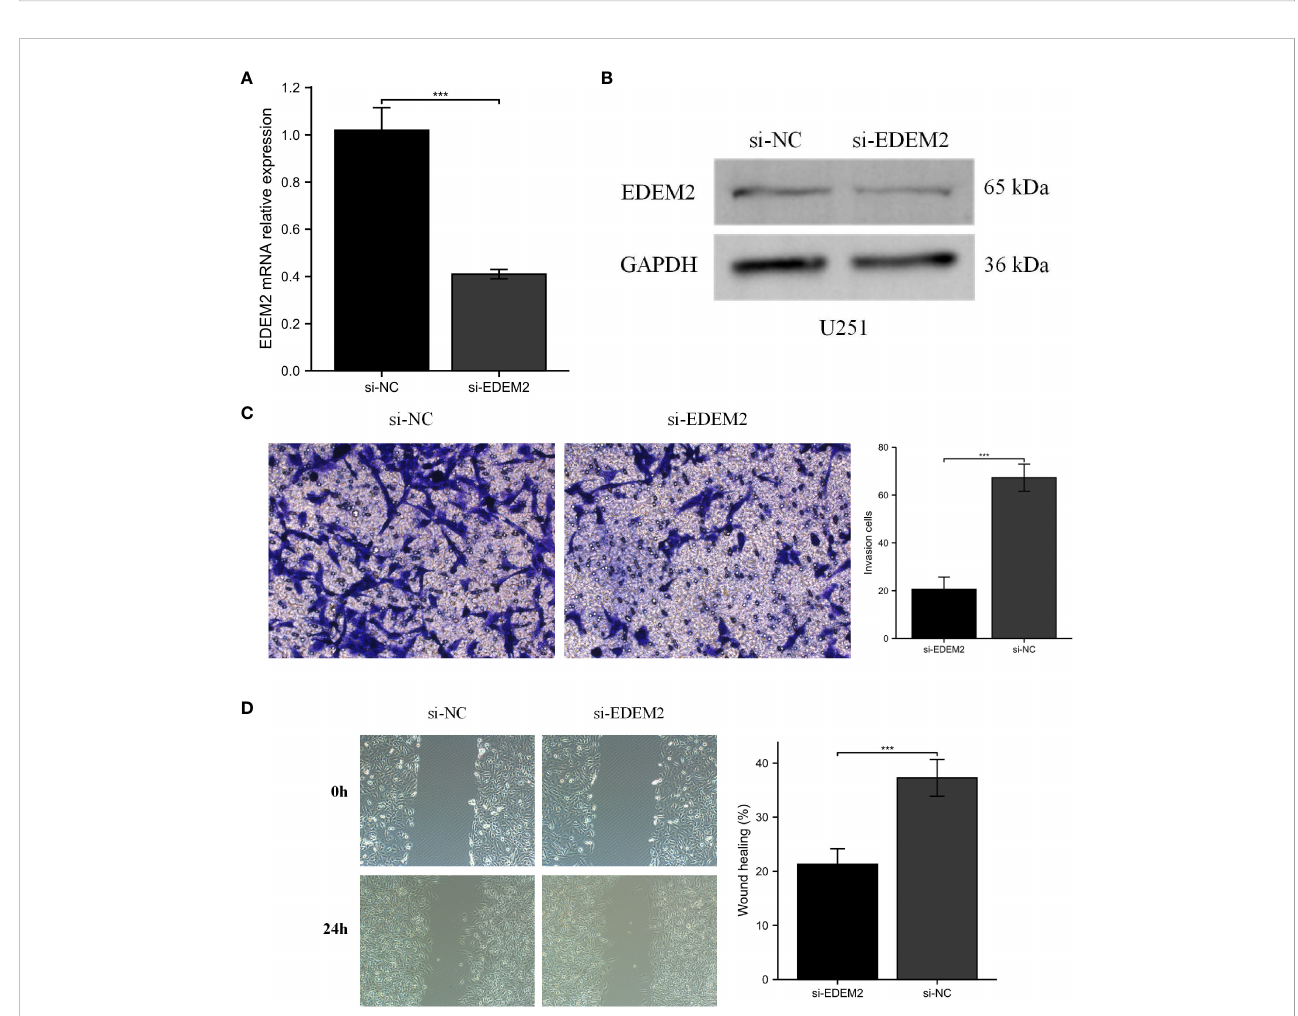
FIGURE 10 Cell experiments of EDEM2 knockdown. (A, B) qPCR and Western blot veri fi ed the knockdown status of EDEM2. (C, D) the migration and invasion abilities of U251 cells were inhibited by wound healing and transwell assays. ***, P <